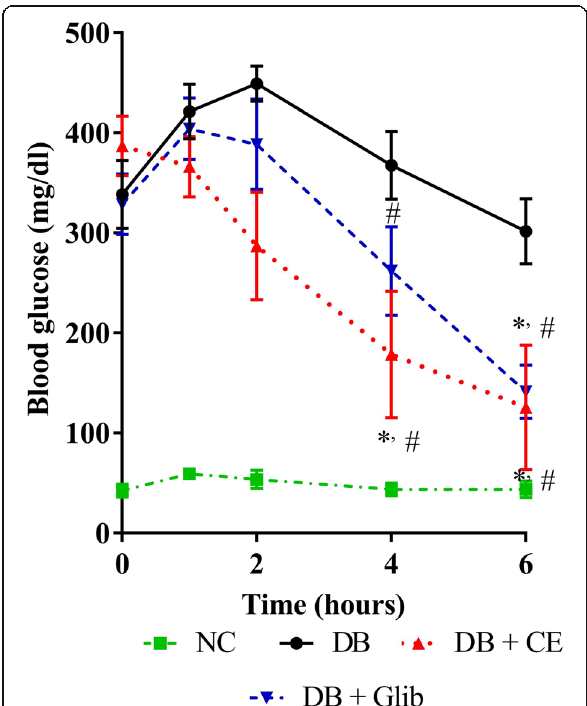
Fig. 3 Acute effect of C. cainito extract on alloxan-induced diabetic mice. NC: normal control; DB: diabetic control; DB + CE: diabetes + CE 500 mg/kg; DB + Glib: diabetes + glibenclamide 10 mg/kg. * P < 0.05 compared with diabetic control mice at the same time of experiment, # P < 0.05 compared to the initial level in the same treatment by one-way ANOVA followed by Student-Newman-Keuls as post hoc test. The values are expressed as mean ± SEM, n = 5 – 6